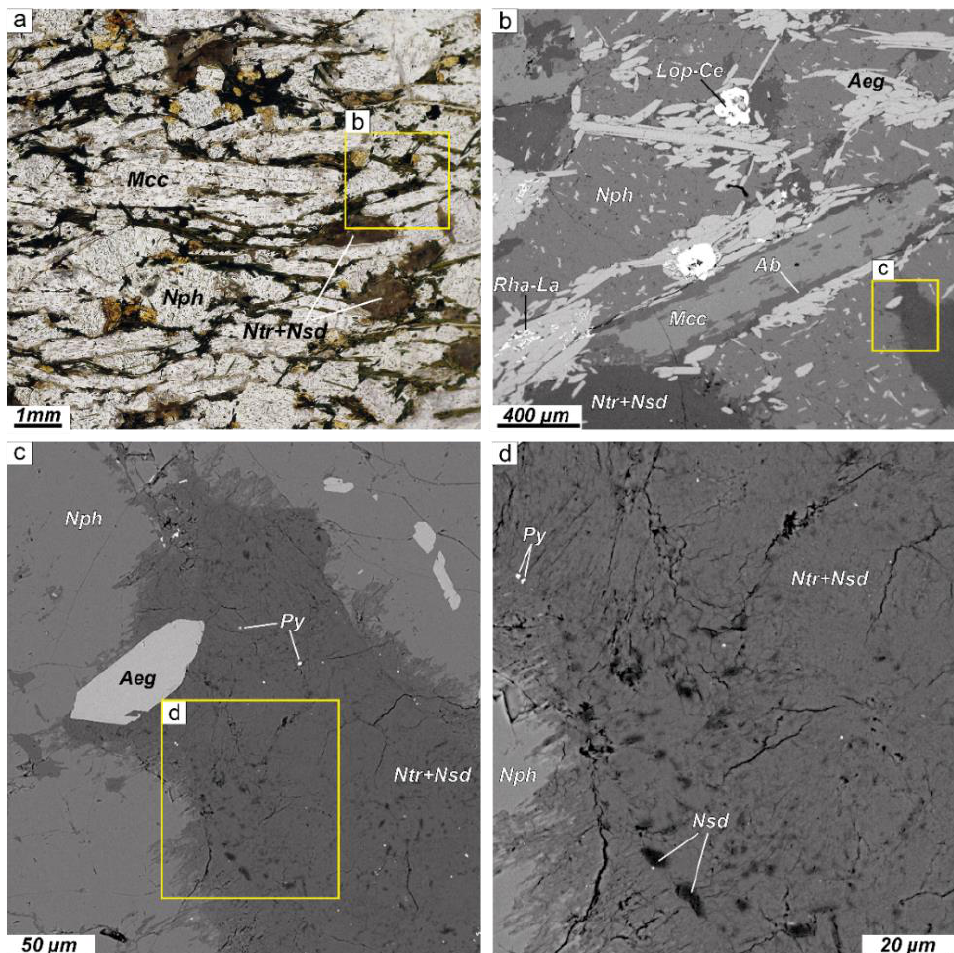
Figure 3. Replacement of nepheline with natrolite + nordstrandite aggregate in lujavrite of the Layered complex. ( a ) Cloudy, opaque areas occupied by the secondary natrolite + nordstrandite aggregates; photo of a thin section under transmitted light; ( b ) intensive replacement of nepheline with an aggregate of natrolite and nordstrandite along grain boundaries; BSE image; ( c ) and ( d ) detailed BSE images of nepheline alteration products. Sample LV-319A.